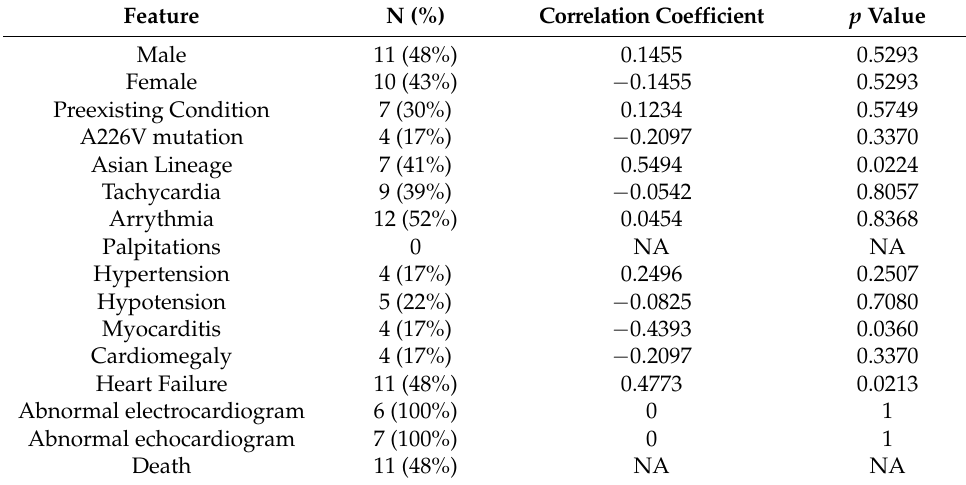
Table 4. Incidence of specific features of CHIKV-infected patients with cardiac symptoms. Pearson’s Correlation Coefficients were obtained to determine if there were any specific features associated with death.